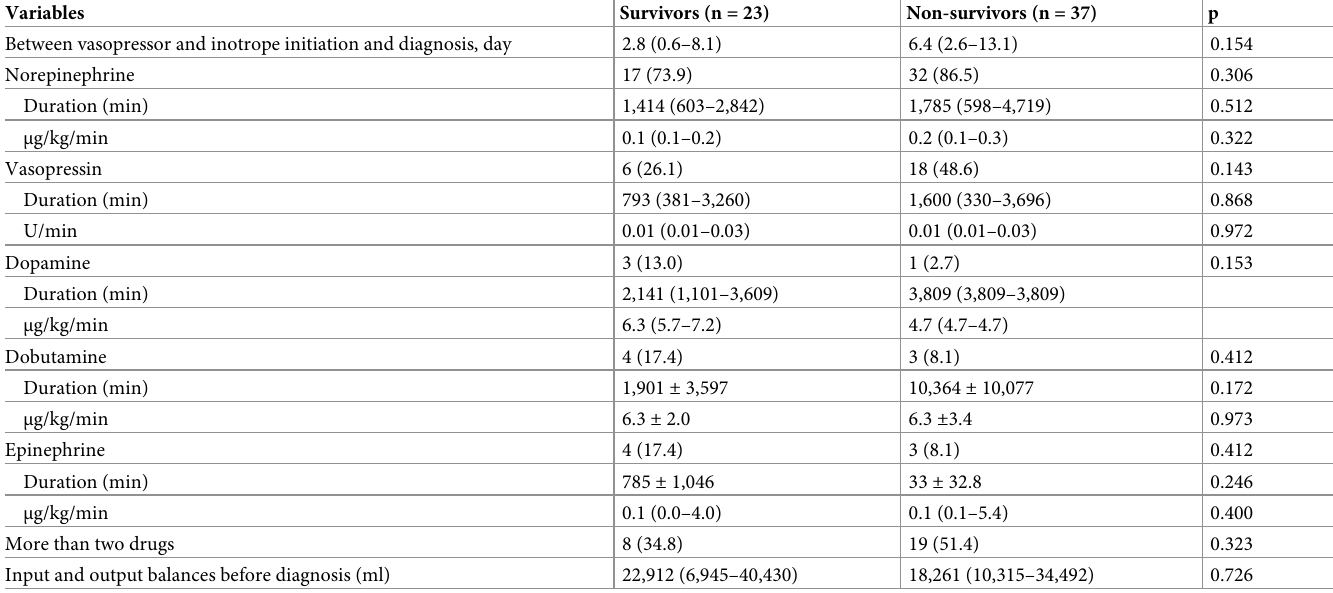
Table 3. Vasopressor and inotrope administration prior to the NOMI